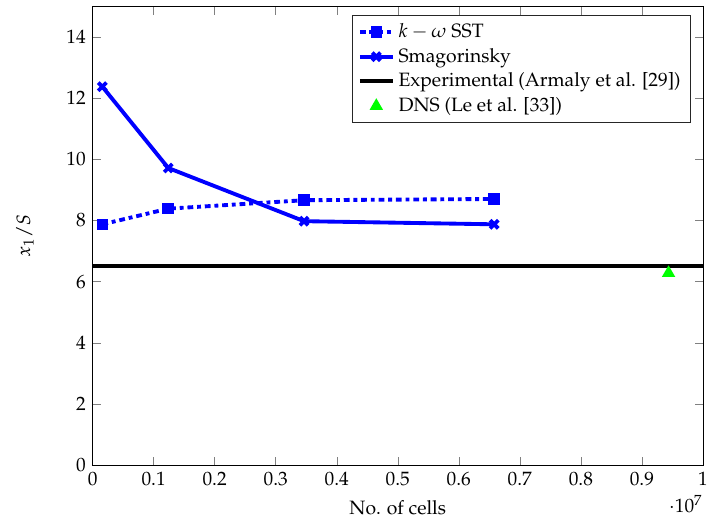
Figure 4. A mesh resolution study was performed on the four meshes outlined in Table 2. The primary recirculation zone normalised by the step height, S , ( x 1 / S ) was used to compare the different mesh